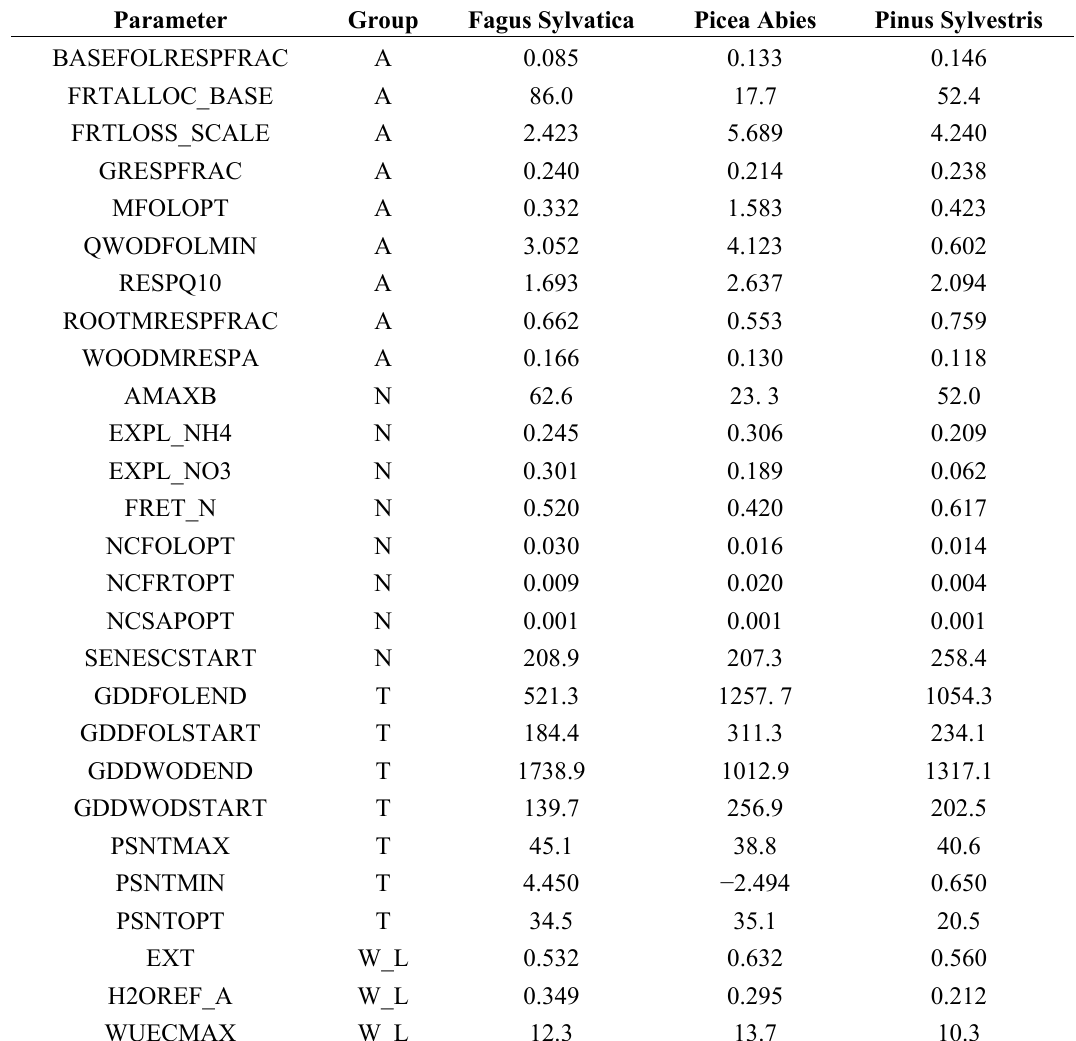
Table 4. Summary of physiological parameters obtained by multi-site calibrations per species type. Parameters are grouped by allocation and respiration (A), nitrogen availability (N), temperature (T) and water availability and light extinction